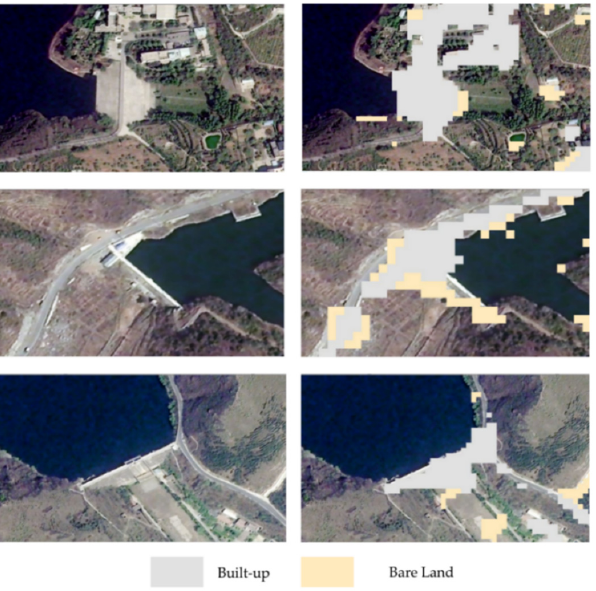
Figure 8. Overlap dam image with built-up and bare land from the ESA Global Land Cover